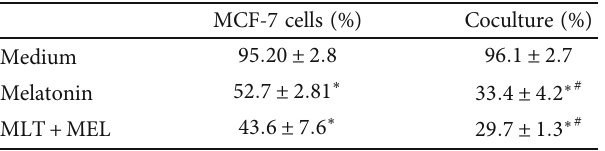
Table 2: Cellular proliferation index of MCF-7 cells and cocutlure (PMN cells + MCF-7 cells).